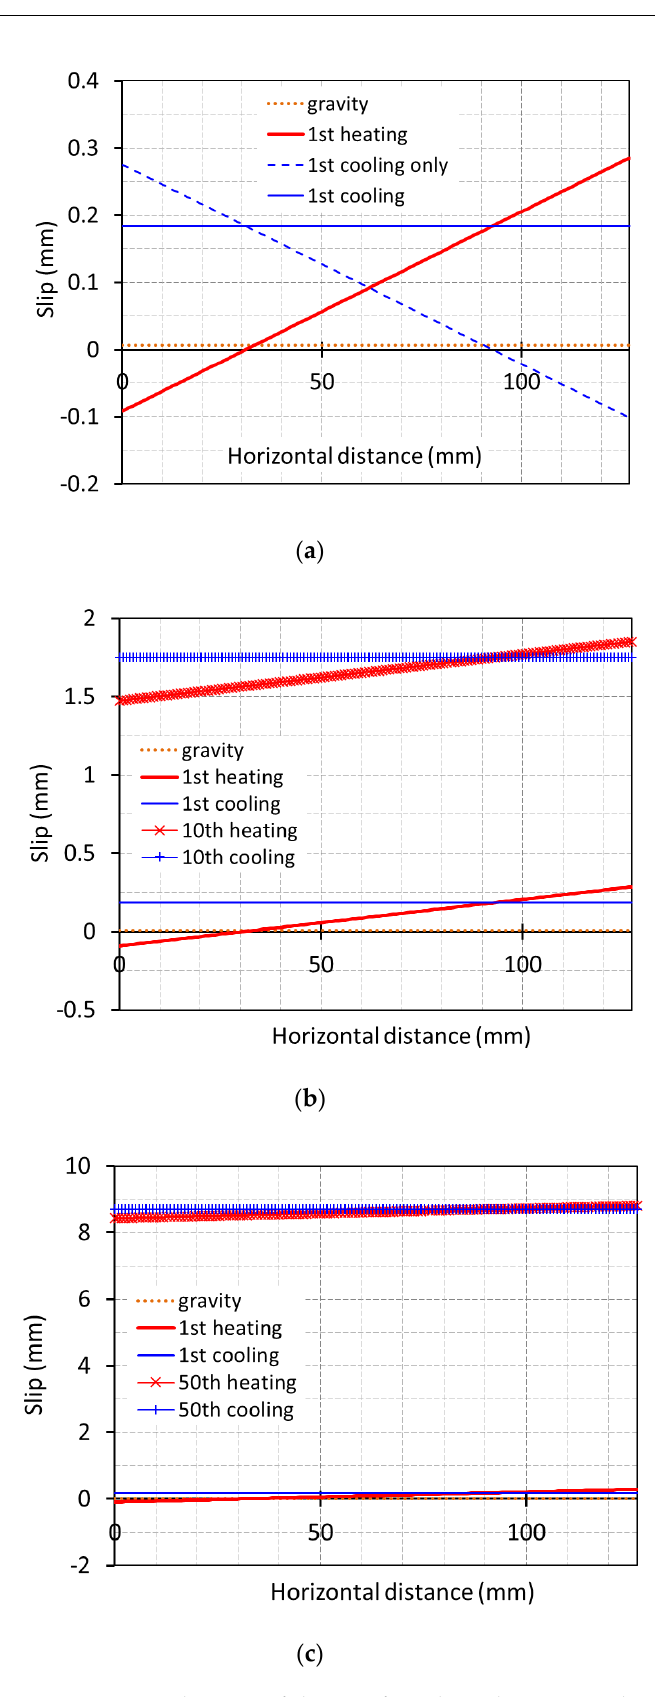
Figure 14. Distributions of the interface slip. The presented results are based on ∆𝑇 = 31℃ in 𝛽 = 10° slope with the parameters in Table 1. ( a ), ( b ), and ( c ) are the same as in Figure 11.